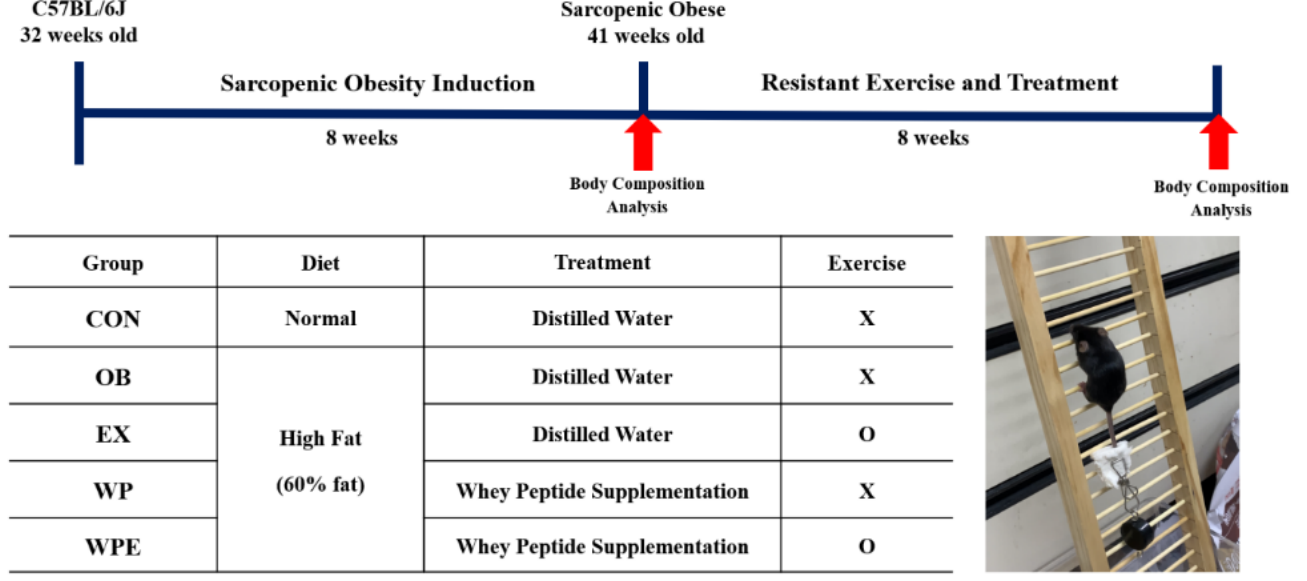
Figure 1. Experimental design. X: non-exercise; O: exercise.